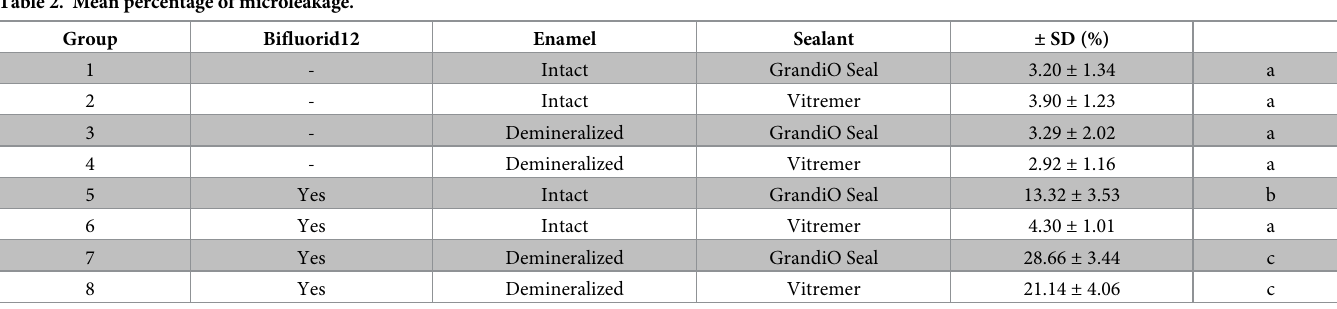
Table 2. Mean percentage of microleakage.